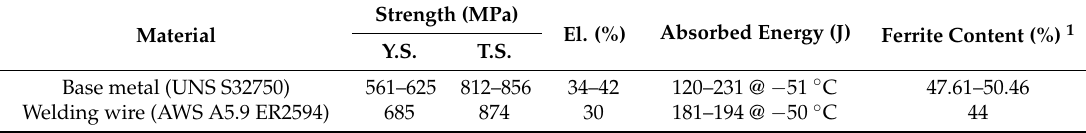
Table 2. Mechanical properties of the base metal and weld metal.